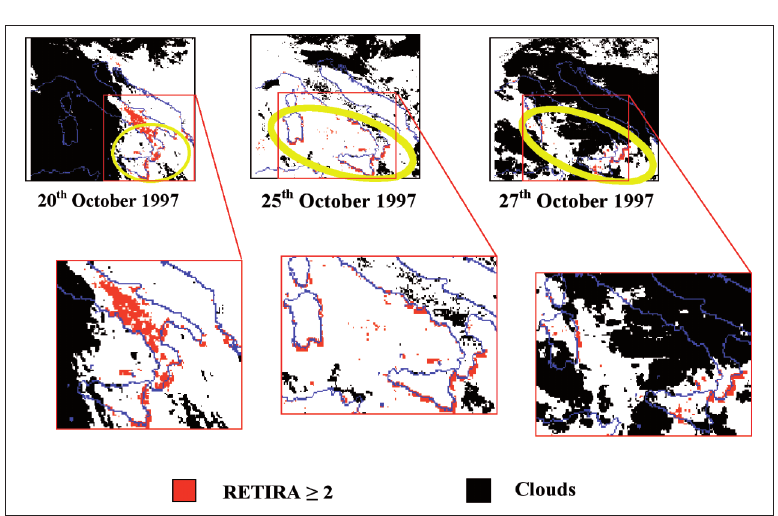
Fig. 3. Validation: images we found affected by navigation errors (see text). The effects are visible near the in- shore lines (yellow circles); on the bottom, a closer view of the coastal areas.